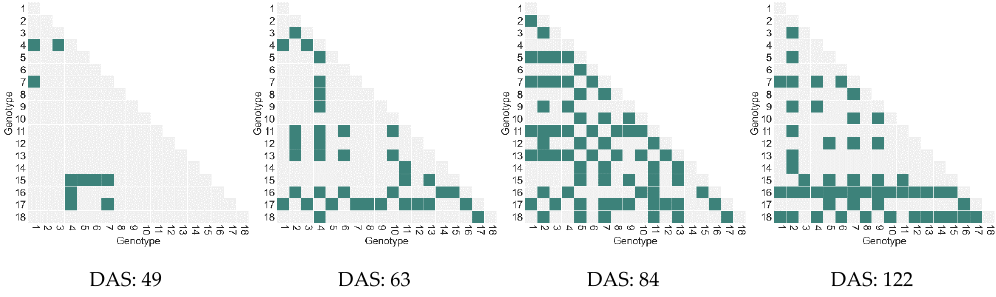
Figure 11. Multiple-comparison Tukey’s test for the OSAVI index for the 18 genotypes planted in HyCal-17 experiment collected throughout the 2017 growing season. Green shows the two varieties are significantly different from each other (α = 0.05).